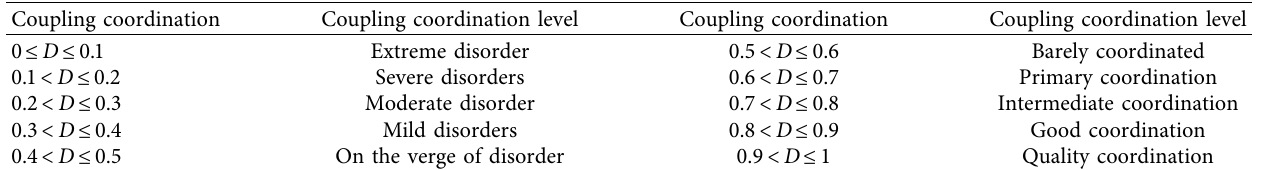
Table 1: Grading criteria for coupling coordination.